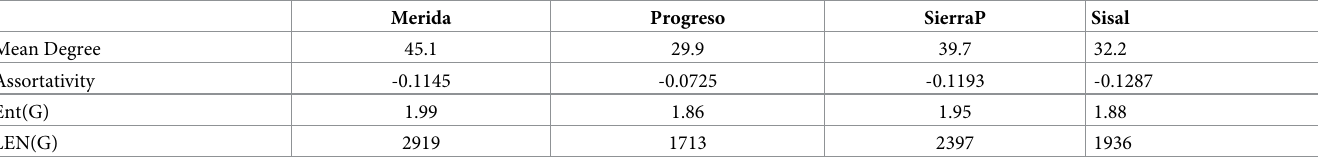
Table 3. Results for the networks generated by averaging the months in 2015 and 2016 per city.